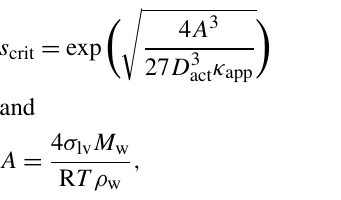
Figure 1. Experimental setup used for obtaining sized CCN and particle concentration measurements from an aerosol